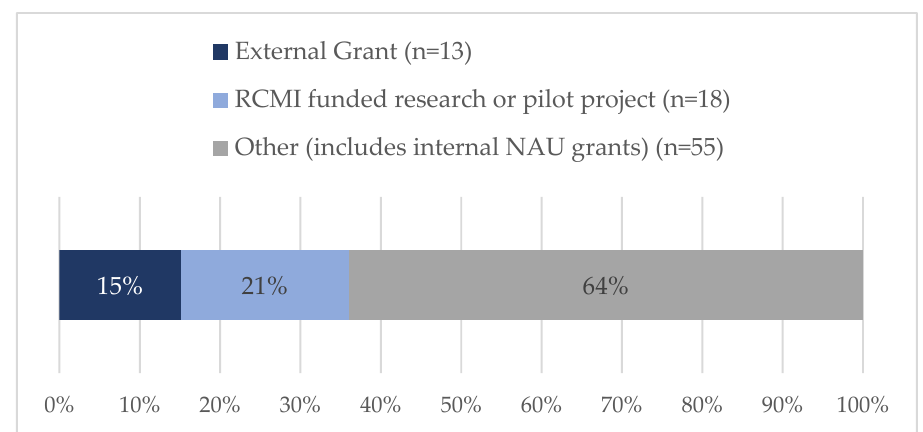
Figure 5. Project type associated with each request through the TAG-SC during Phase II: Pilot Year and Phase III: Year 1 of TAG-SC (N = 86).